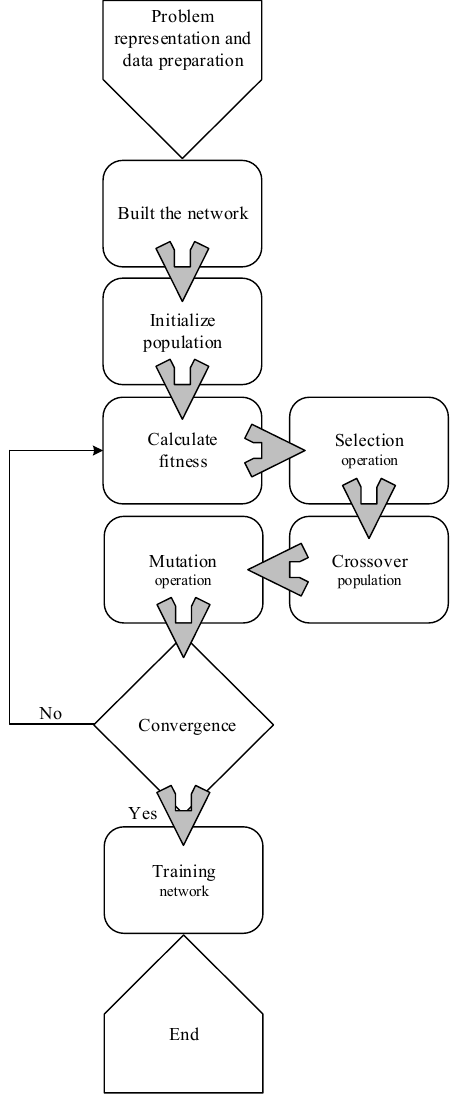
Figure 5. Flowchart of a GNN.